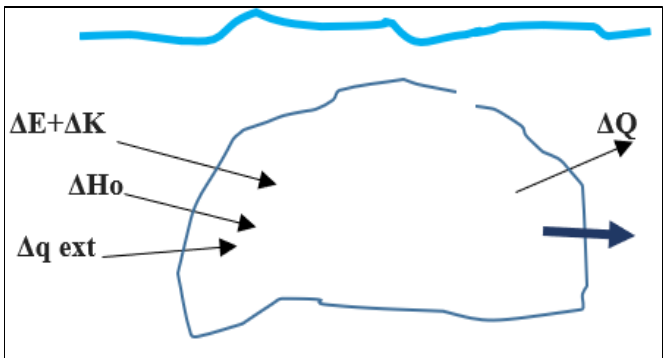
Figure 2: System´s energies and in its surroundings.